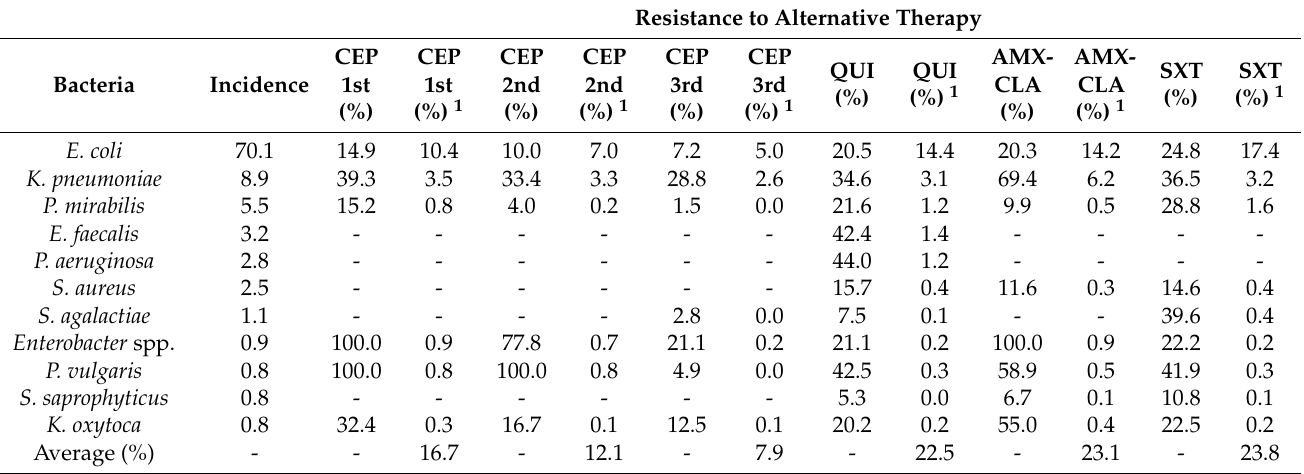
Table 5. Calculated bacterial resistance to the antimicrobials recommended as alternative therapy for empirical treatment of UTI.